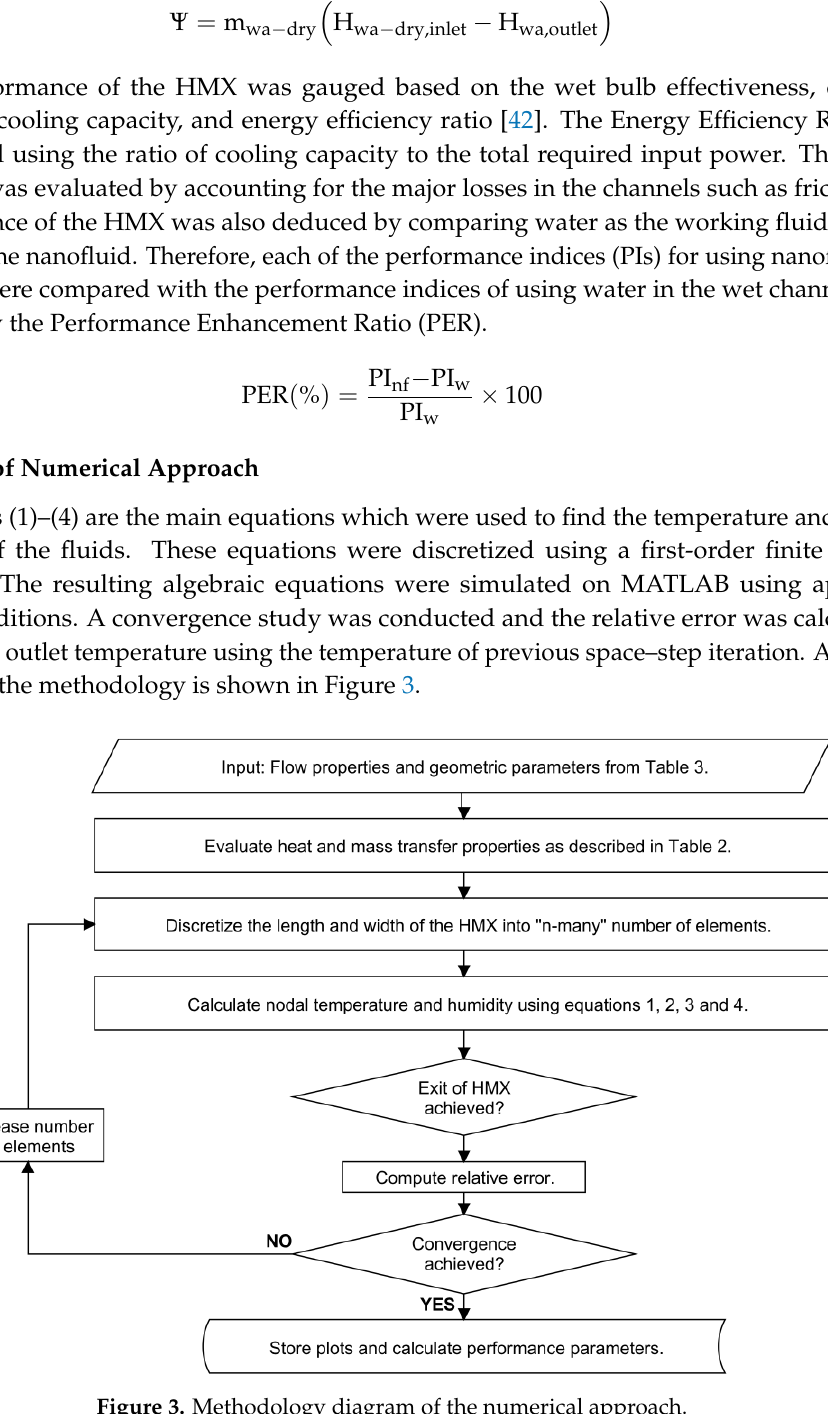
Figure 3. Methodology diagram of the numerical approach.